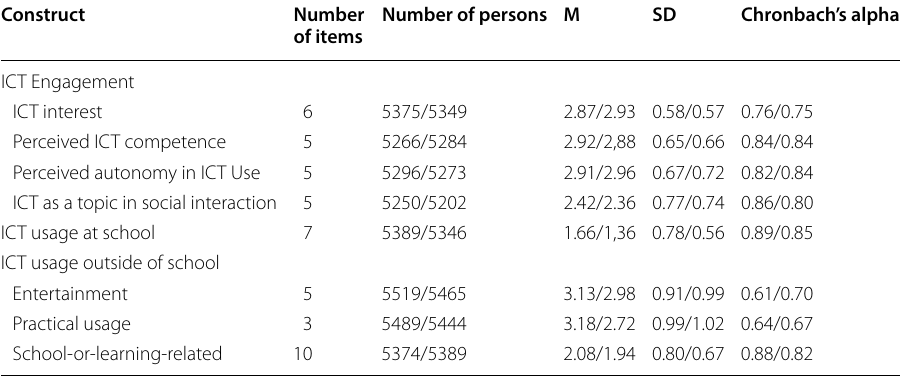
M means score; SD standard deviation